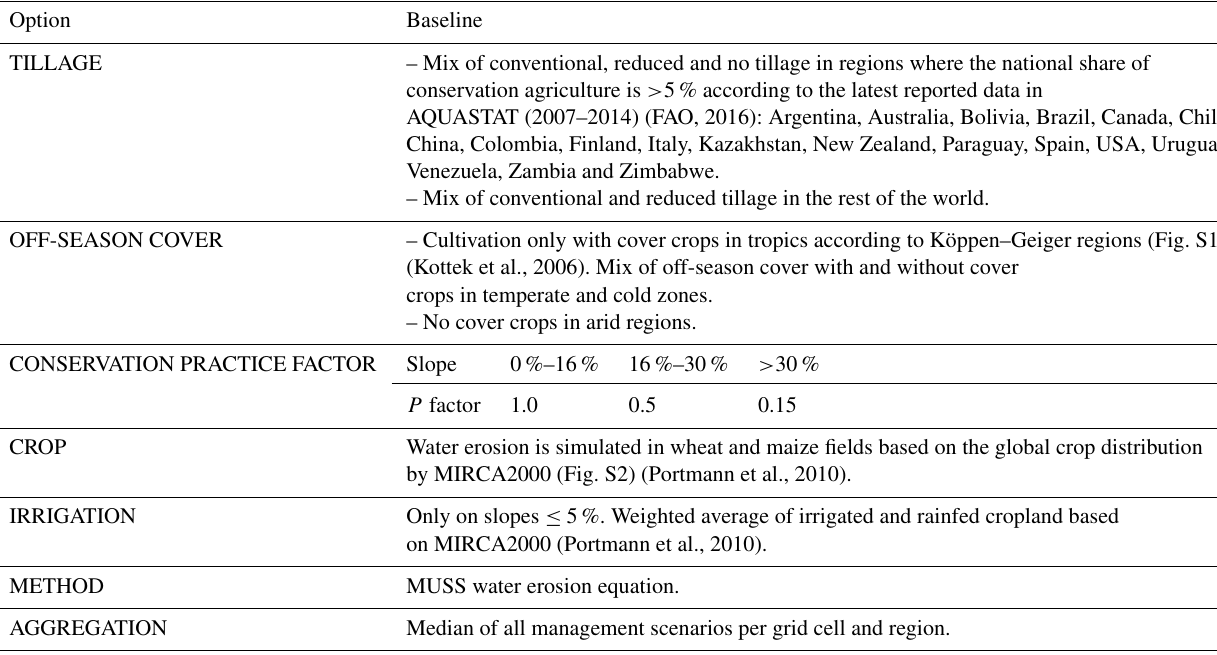
Table 3. Management assumptions and erosion equation selected for the baseline